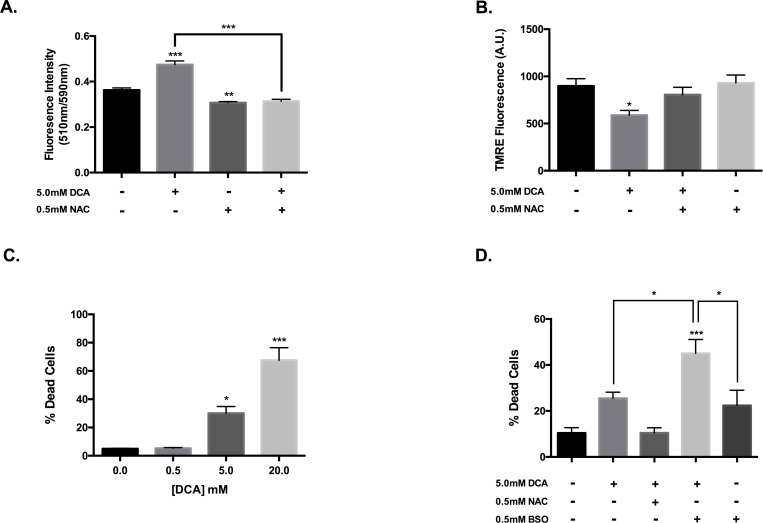
DCA cytotoxicity is dependent on oxidative stress.(a) Ratiometric detection of BOPIDY® 581/591 oxidation as an indicator of lipid peroxidation in VM-M3 cells following 4-hour treatment with DCA ± NAC. (b) Quantification of average TMRE fluorescence intensity following 4-hour DCA treatment ± N-acetylcysteine (NAC). (c) Analysis of VM-M3 viability following 24-hour treatment with DCA. Bars represent fraction of cells stained positively for ethidium homodimer-I (Ethd-1). (d) Evaluation of VM-M3 viability following 24-hour DCA treatment in the presence of modulators of glutathione availability. (a-b) Error bars represent SEM of a single experiment replicated in triplicate (c-d) Error bars represent SEM of three experimental replicates; *p<0.05, **p<0.01, and ***p<0.001.